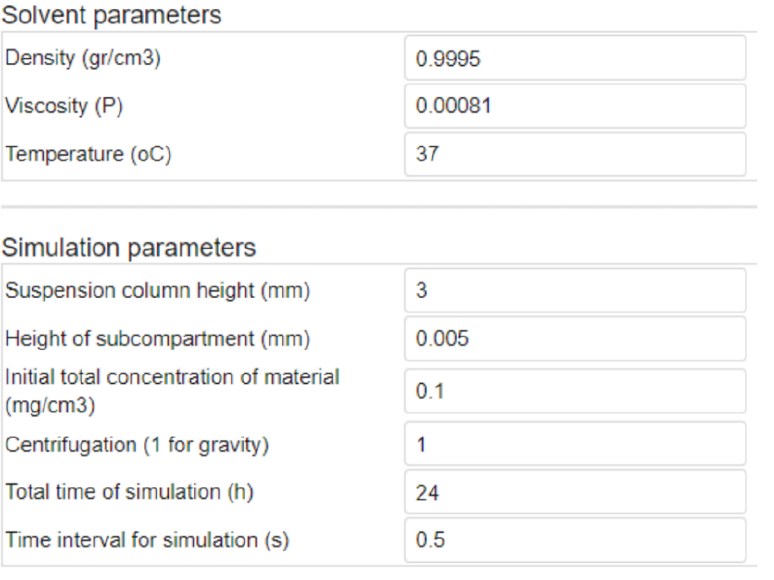
Figure 3. The Solvent parameters needed as input, shown in this case for ultrapure water, and the Simulation parameters section, which are used to describe the vessel in which the NPs are dispersed or the cell culture dish in which the NPs are administered. The Advanced parameters section. ( a ) The basic input which gives information on the rates of sedimentation and diffusion (default values are set to zero) and describes the dissolution status of the NPs ’ dispersion and the rate of dissolution (if any), and whether an attachment factor is required, for example, due to the presence of an adher- ent layer of cells at the bottom of the well. ( b ) Example of Dissolution fraction versus time, t (in hours), if the user selects to specify times and fractions in Dissolution rate type. The Output param- eters section, where the user selects the time period for the simulation, the height of the exposure vessel (e.g., the cell culture dish) and whether they want to record the NPs ’ concentrations through- out the vessel or only for the bottom layer. Finally, the Advanced parameters section (see Figure 3) allows the user to define spe- cific input properties concerning the simulation. The latter includes the sedimentation and the diffusion coefficients. The sedimentation coefficient takes into account the dependence of the sedimentation process on the initial particle concentration, as this varies in a non- linear way [35] as presented in Equation (1).